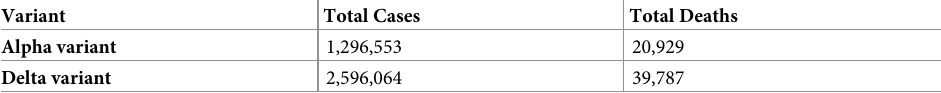
Table 2. The number of total cases and deaths in Alpha and Delta variants of COVID-19 in Iran.